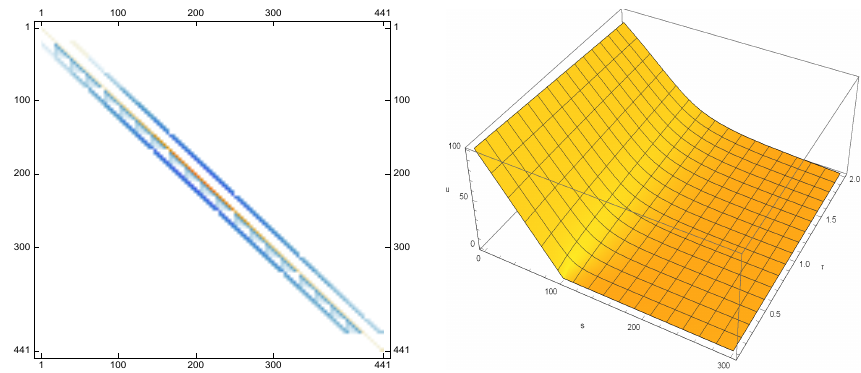
Figure 3. Numerical results in Test Problem 2 for PM based on m = n = 21. ( Left ) The sparsity pattern of the coefficient matrix in (35). ( Right ) Time fractional option pricing